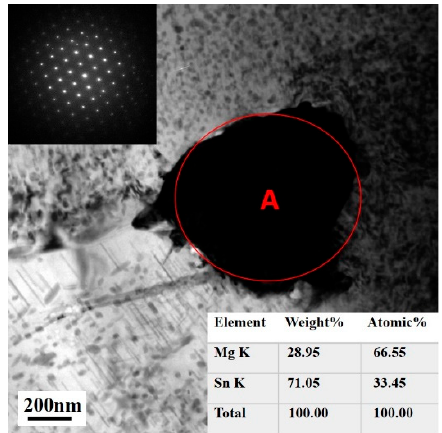
Figure 14. Bright-field TEM image of a representative inter-dendritic Mg 2 Sn particle. Inset image is